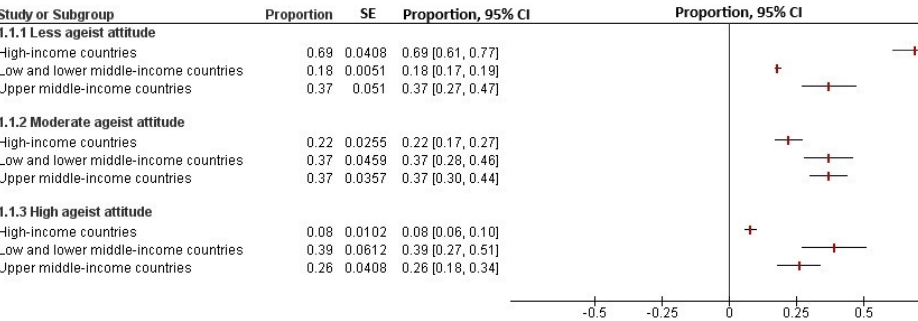
Figure 2. Meta-analysed estimates of individual-level ageist attitudes class by country income level.